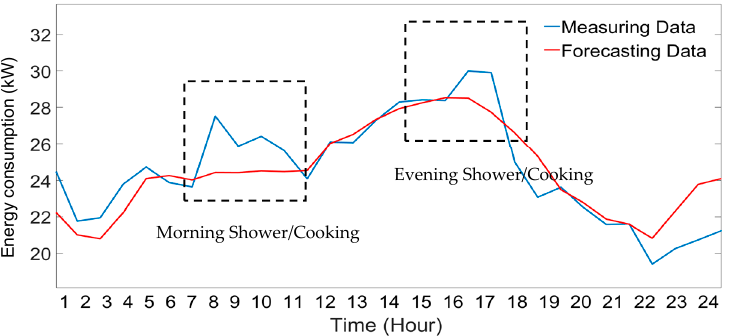
Figure 5. One-day heat consumption of the building with morning and evening shower peaks.